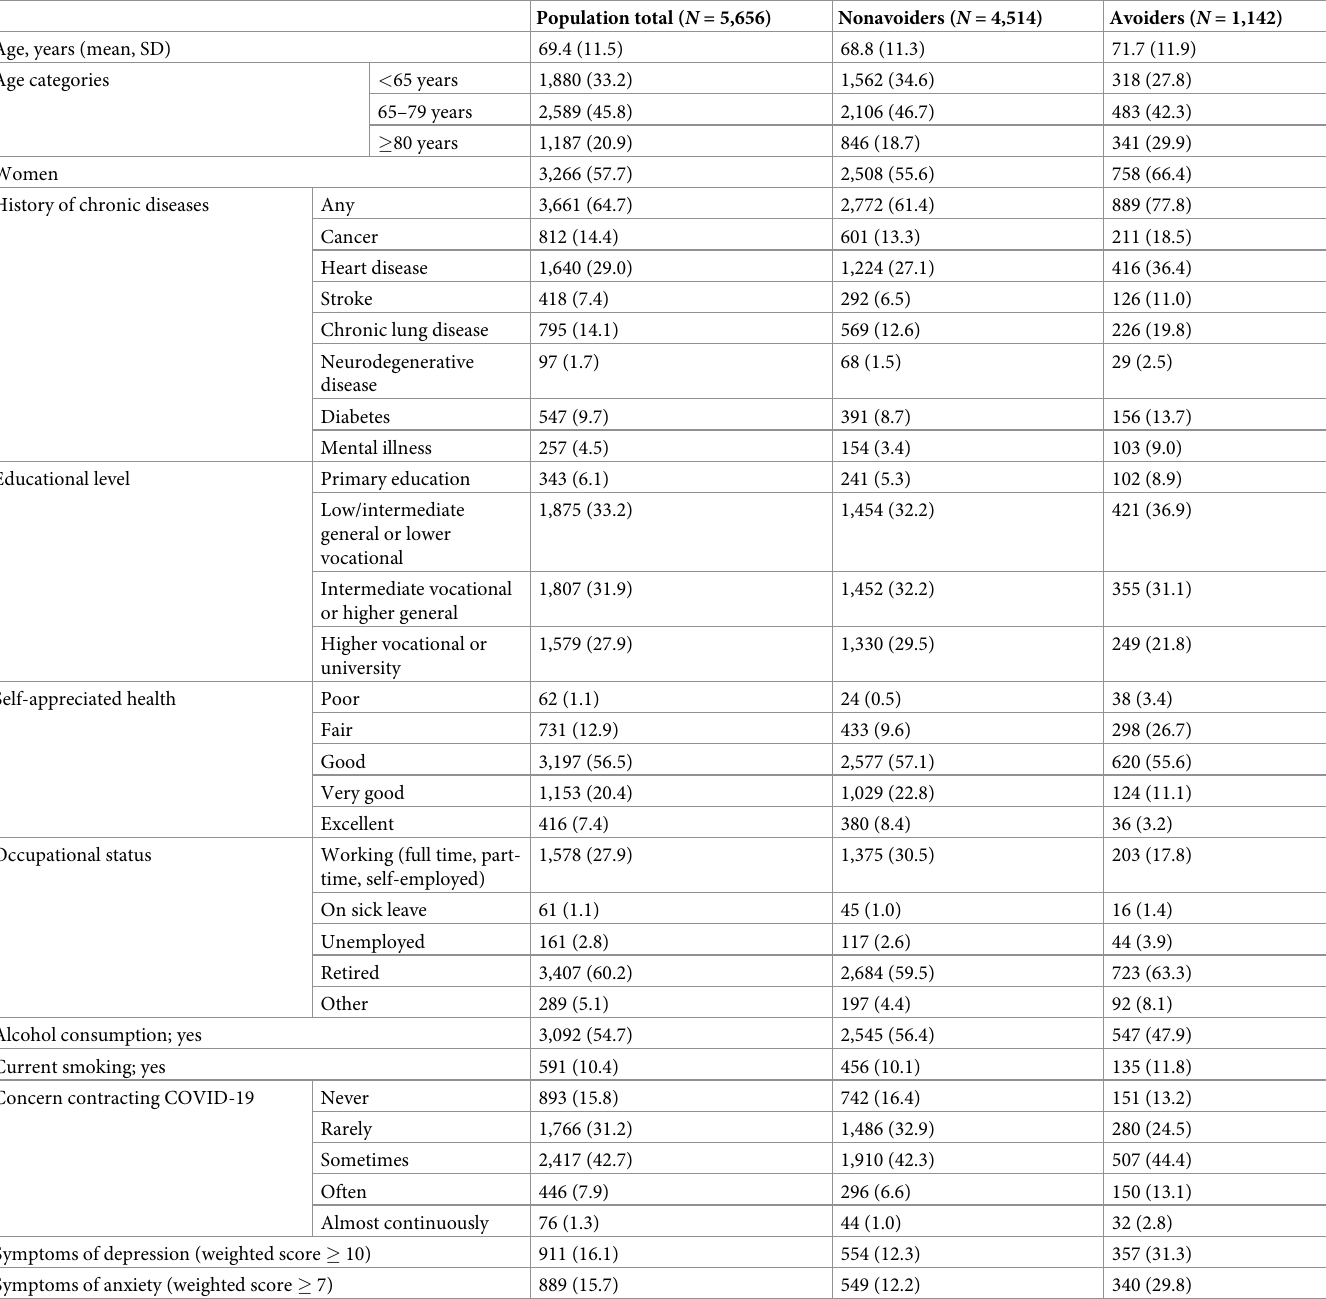
Table 1. Characteristics of the study population ( N = 5,656). Values are numbers (percentages) unless stated